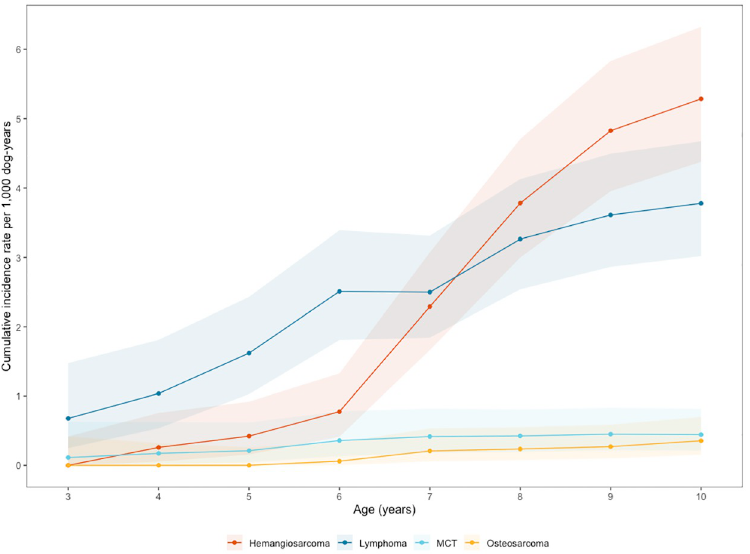
Fig 3. Cumulative incidence of the four primary endpoints. Cumulative incidence is shown by dog age in years and the shaded areas represent 95% confidence intervals. All diagnostic tiers (1–3) are included in incidence